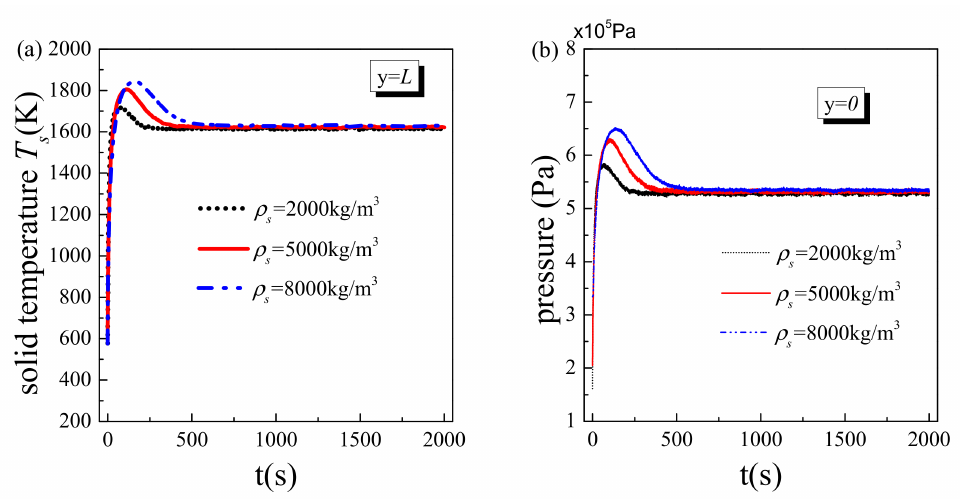
Figure 8. Transient results at different solid density: ( a ) solid temperature at the hot side; ( b ) fluid pressure at